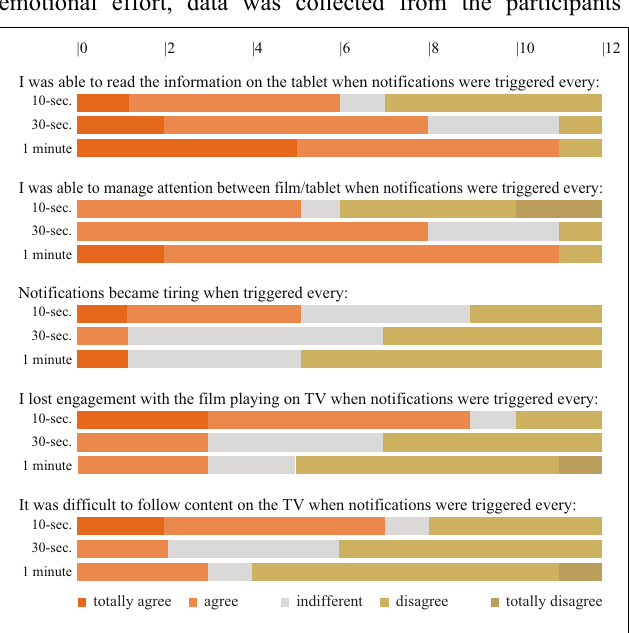
Figure 3 - Participant's opinions regarding notification's